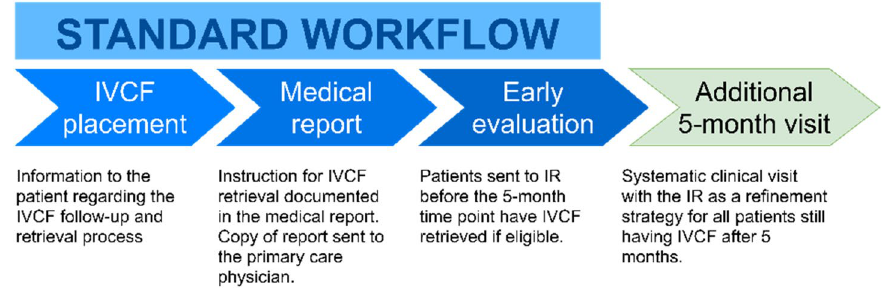
Figure 1. Prospective longitudinal study design. IVCF inferior vena cava filter, IR interventional